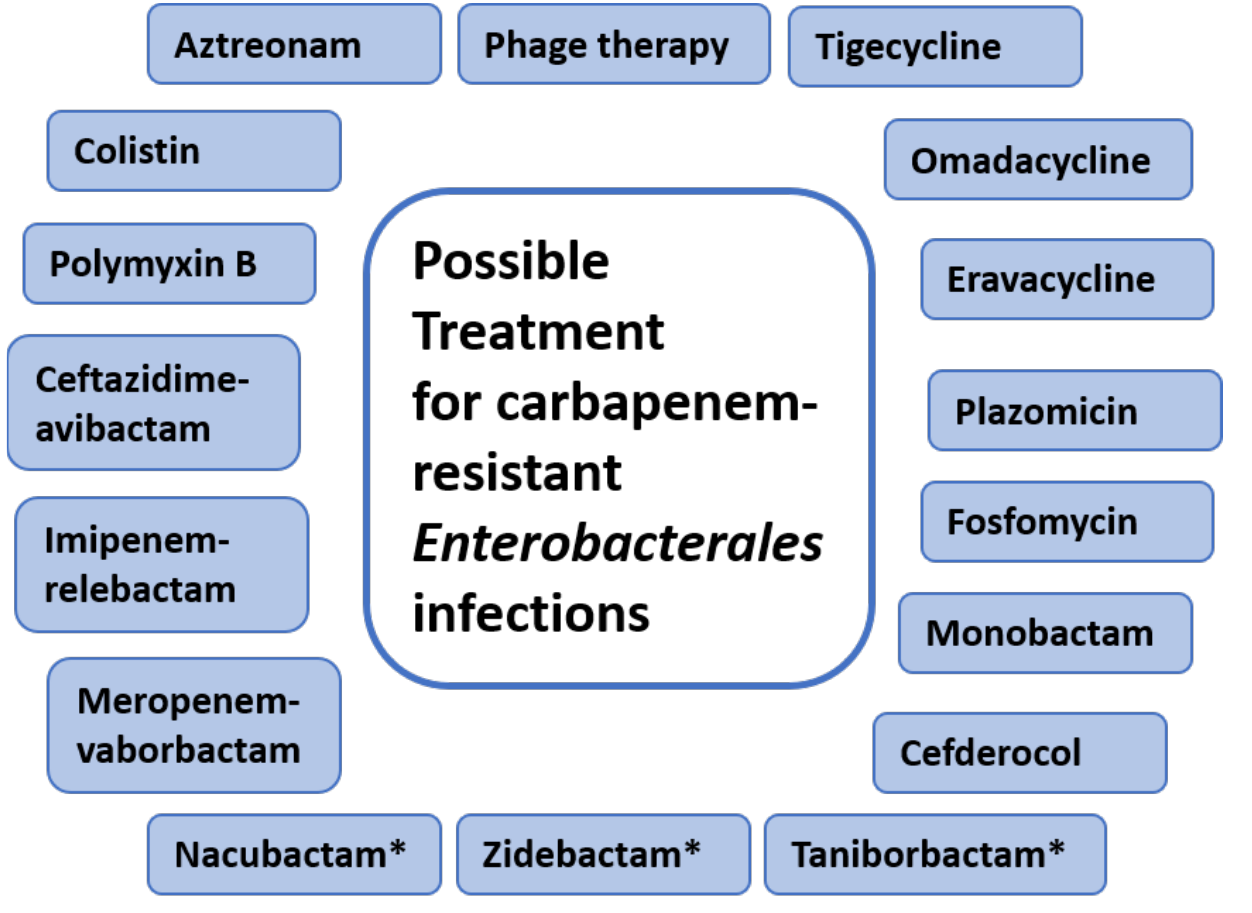
Figure 2. Possible therapeutic options for treatment of infection by CRE. * Represents the antibiotics that are currently under development processes or under clinical trials. that are currently under development processes or under clinical